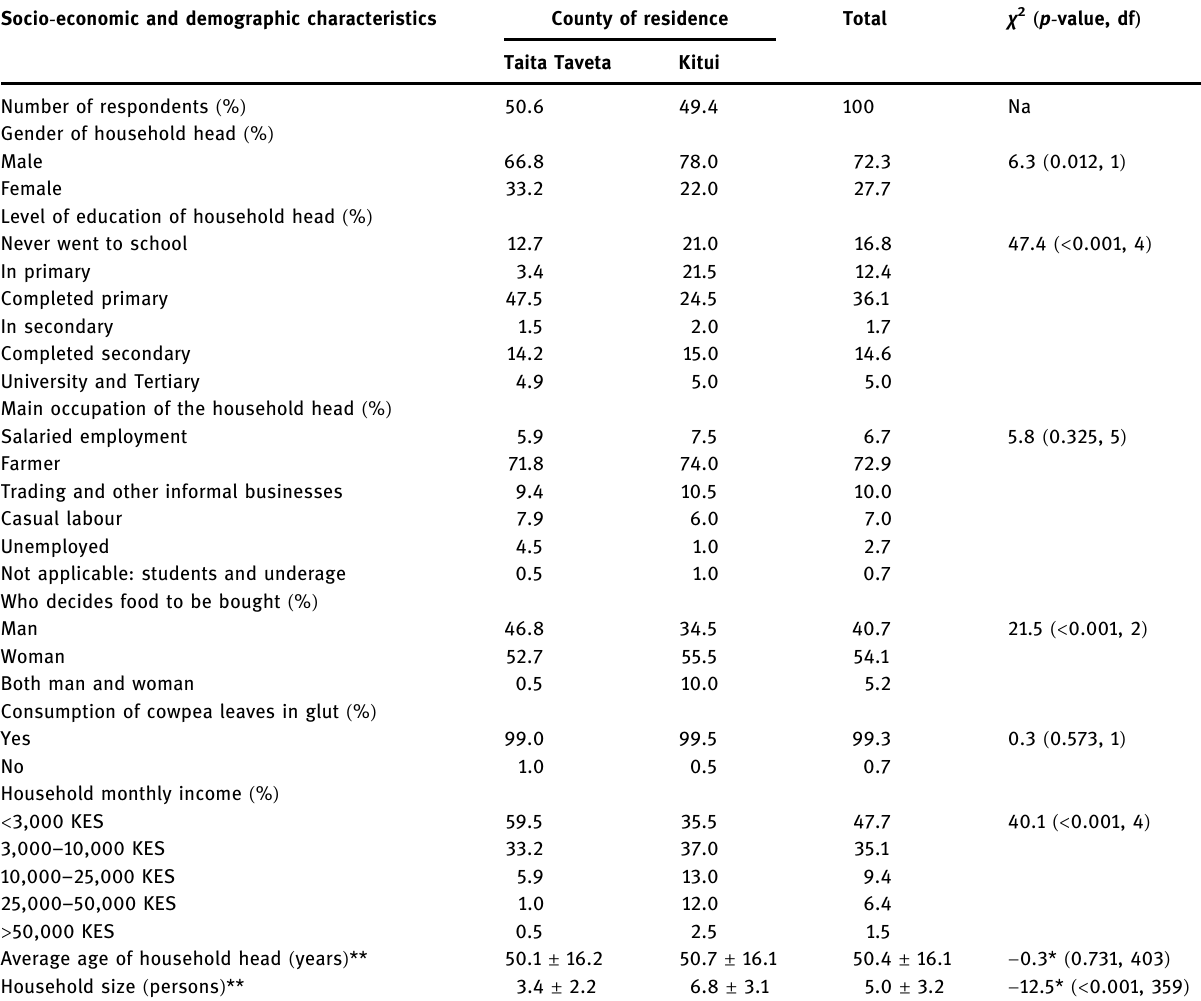
Table 1: Socio - economic and demographic characteristics of households producing cowpea leaves Socio - economic and demographic